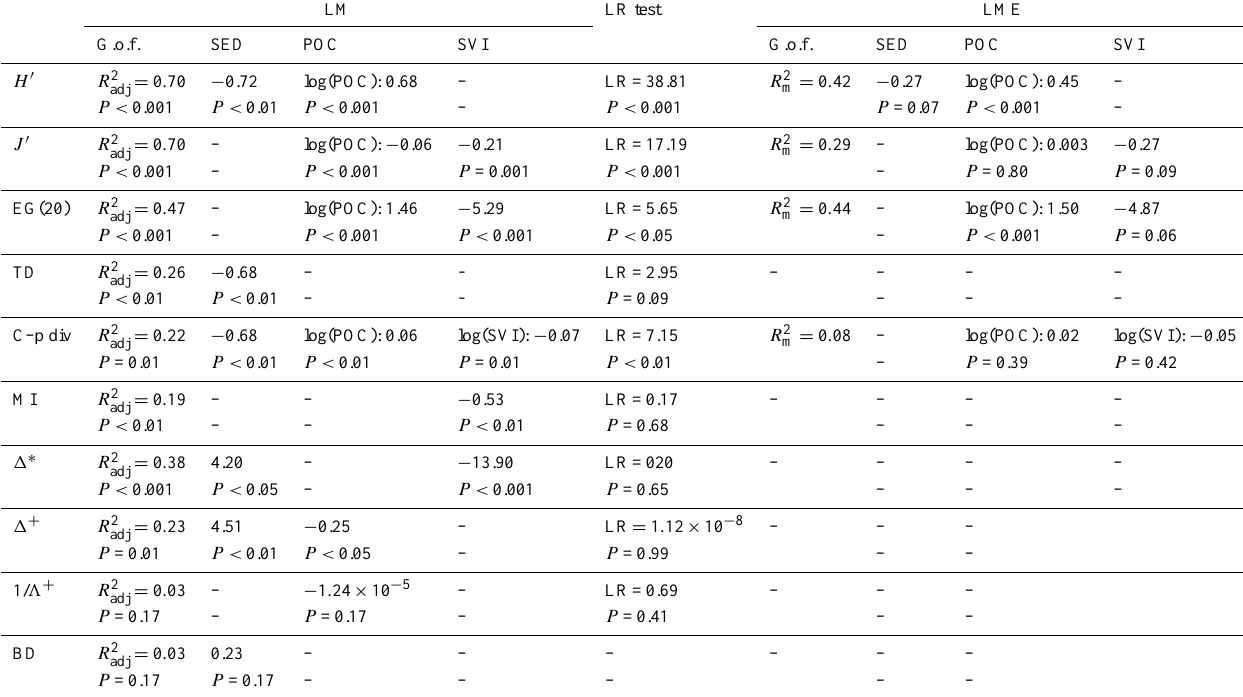
Table 3. Results of linear models (LM), the likelihood ratio (LR) test and linear mixed-effect models (LME) for the regression of sediment particle size diversity (SED), seafloor particulate organic carbon flux (POC) and seasonal variability in POC flux (SVI) against nematode diversity. The estimated size of the effect and the associated P value are given per independent variable. For the regressions against H 0 , J 0 , EG(20) and c–p diversity (c–p div), POC was log e transformed to comply with the assumptions of linear regression. For c–p diversity, also SVI was log e transformed to comply with assumptions. H 0 : Shannon–Wiener diversity, EG(20): expected genus richness for a sample of 20 individuals, J 0 : Pielou’s evenness, TD: trophic diversity, c–p diversity: diversity of c–p (life history) classes, MI: maturity index, 1 + : average taxonomic distinctness based on presence–absence data, 1 ∗ : average taxonomic distinctness based on quantitative data, 1/ 3 + : taxonomic evenness, BD: biomass diversity, R 2 : adjusted R 2 , R 2 m : marginal R 2 , and G.o.f.: goodness of adj